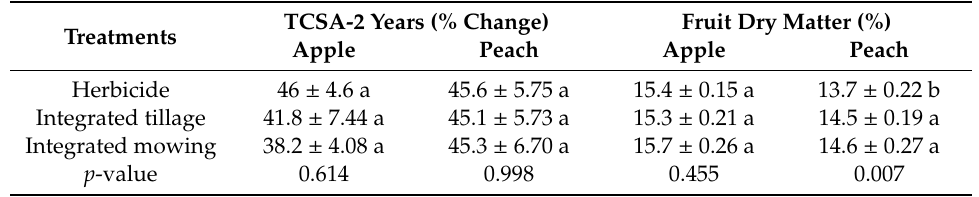
Table 4. E ff ects of integrated weed control methods on trunk cross-sectional area (TCSA) growth and fruit dry matter (%) in apple and peaches during two years